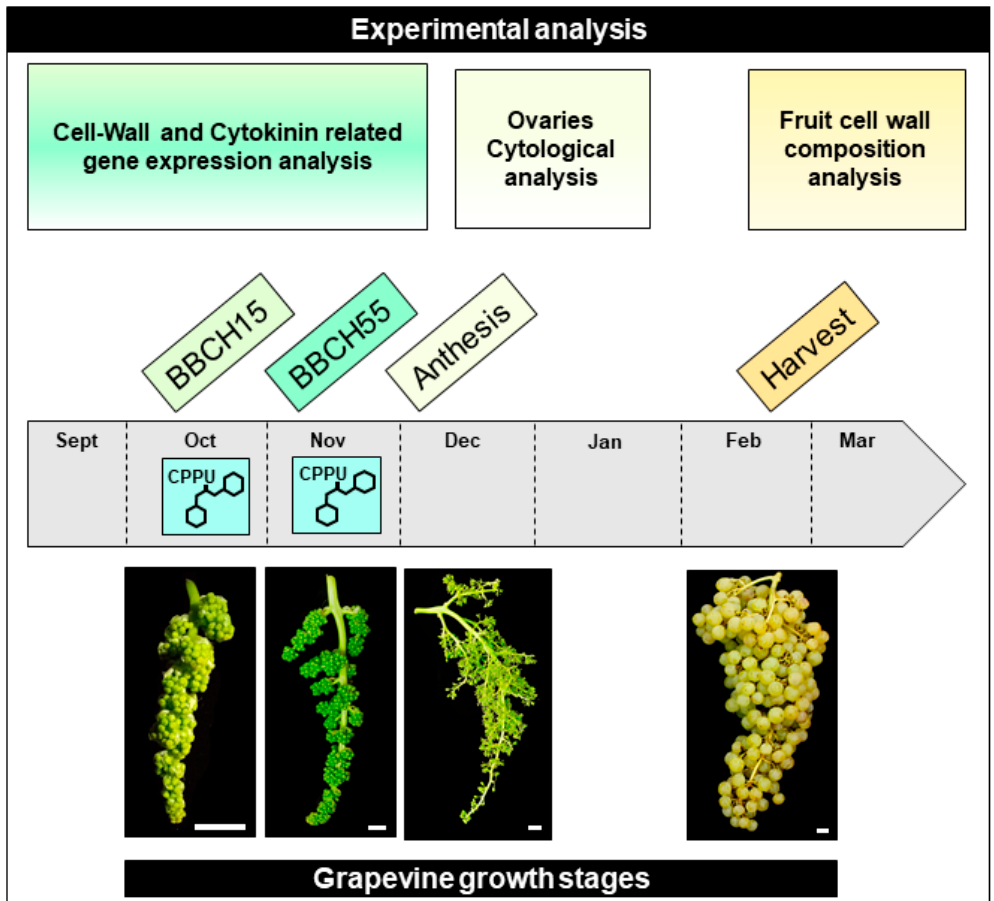
Figure 5. Schematic representation of the experimental design and timeline of grapevine growth stages analyzed in this study. Two CPPU applications were sprayed on inflorescences, the first one at BBCH15 and the second one at the BBCH55 grapevine growth stages. Samples collected at those points were used for relative gene expression analysis targeting cell wall-related and cytokinin-responsive genes. In the same growing season, at the BBCH65 stage (Flowering), when 50% of the caps were off, samples were collected to proceed with the ovary cytological assays by optical and confocal microscopy. In addition, control and treated berries (CPPU) were evaluated for their phenotypes (e.g., hardness, size, and weight) and cell wall composition by HPAEC-PAD, and cell wall calcium content was determined at harvest (BBCH89). Scale Bars = 1